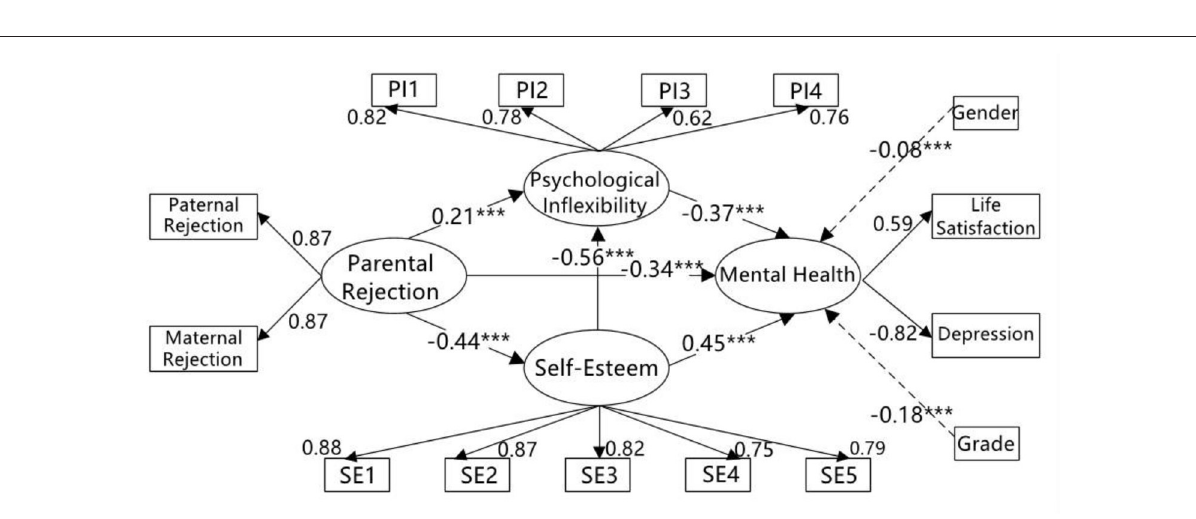
inflexibility). In line with IPAR theory, family systems